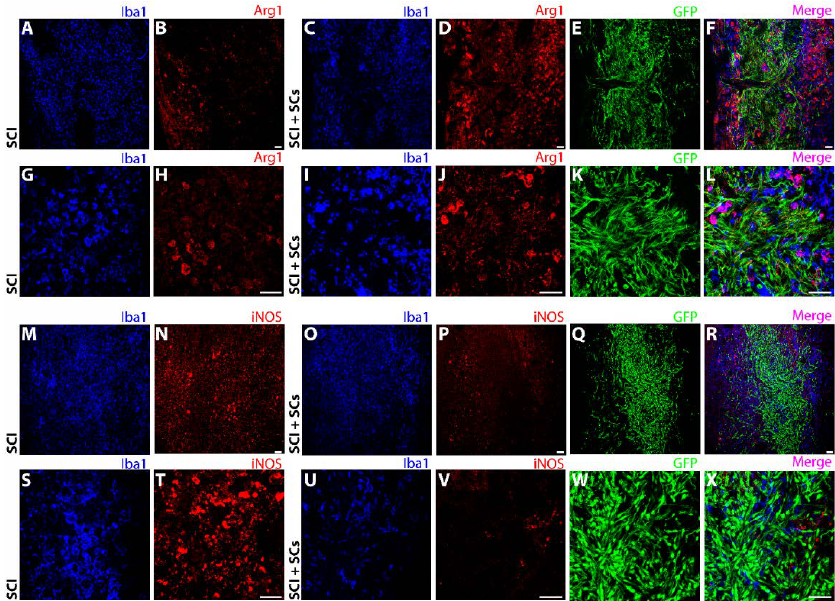
Figure 7. Lesional and perilesional changes in Arg1 and iNOS were observed after SCI and SC transplantation. Immunohistochemical staining showed a pronounced increase in Arg1 immunoreactivity (red) from SCI controls ( A , B , G , H ) to EGFP-SC-transplanted (green) animals ( C , D , I , J ). The increase in Arg1 was most pronounced in the perilesional region and adjacent host spinal cord tissues ( E , F , K , L ). In contrast, compared with SCI controls ( M , N , S , T ), iNOS immunoreactivity (red) was dramatically reduced after EGFP-SC transplantation ( O , P , U , V ), being virtually absent from the lesion–SC implant ( Q , R , W , X ). Total innate immune cells identified using Iba1 (blue). Triple staining of EGFP, Iba1 and either Arg1 or iNOS are shown in the merged images (pink; ( F , L , R , X )). Images were acquired at 10× ( A – F , M – R ) and 40× ( G – L , S – X ) objective magnifications. Scale bar = 50 μm.